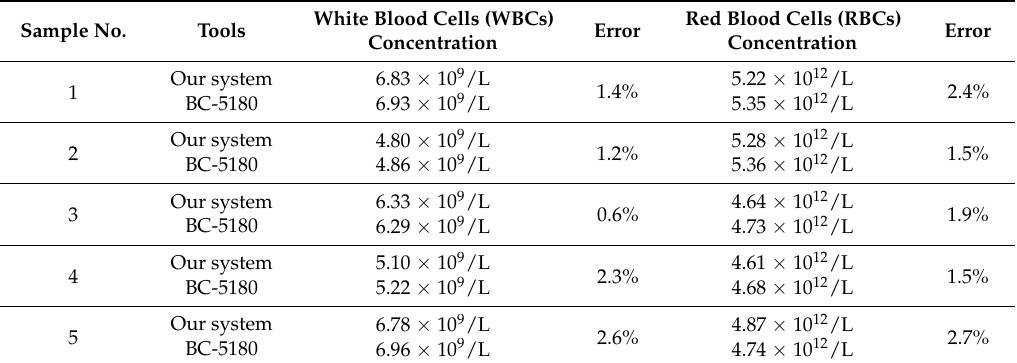
Table 1. The result of different sample